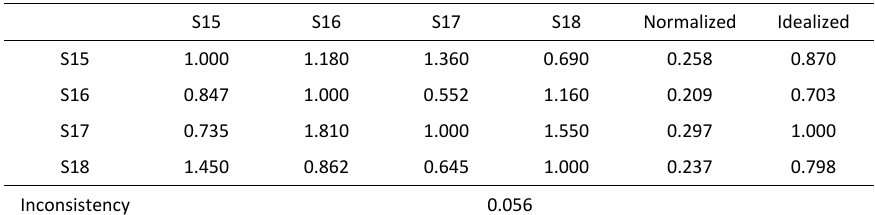
Table 8. Pairwise comparison matrix of rules sub-criteria Table 8: Pairwise comparison matrix of rules sub-criteria